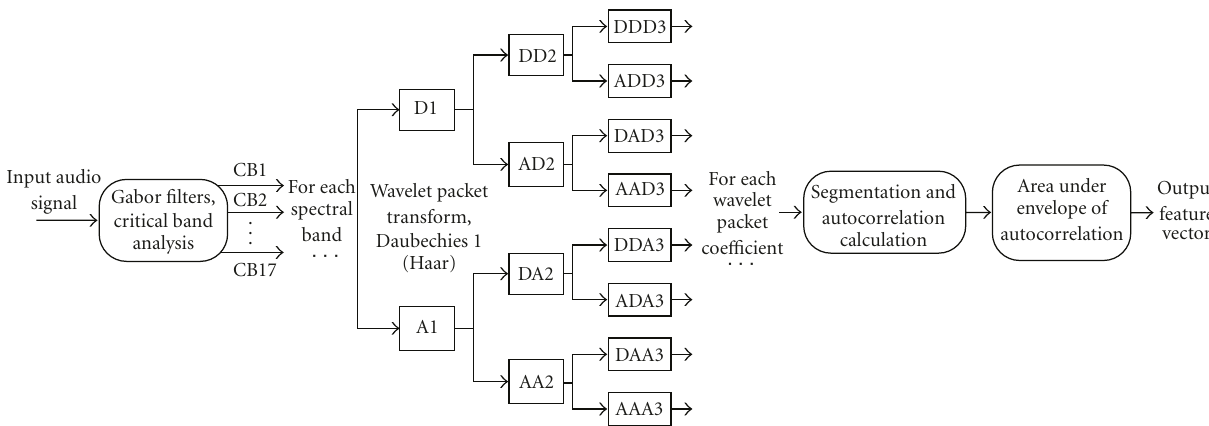
Figure 3: Perceptual wavelet packet integration audio